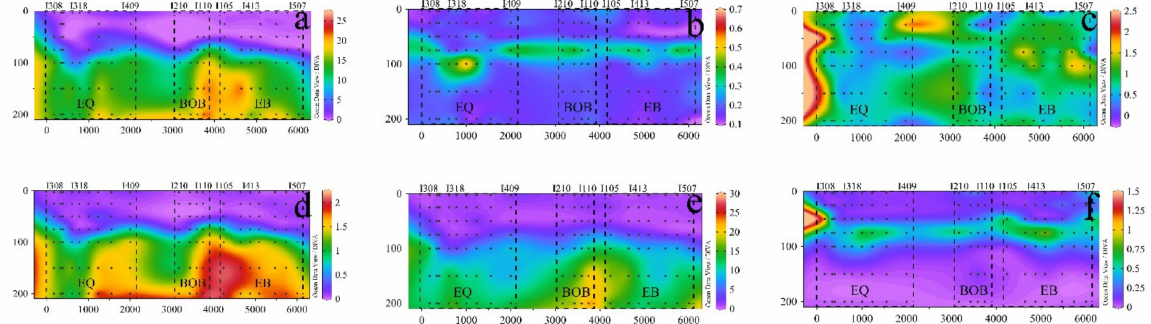
Figure 3. The vertical distribution of Nitrate ( a ), nitrite ( b ), ammonium ( c ), phosphate ( d ), silicate ( e ), and Chlorophyll a ( f ). Bay of Bengal (BOB), the Equator (EQ), and the eastern border of the Indian Ocean near Sumatra (EB).